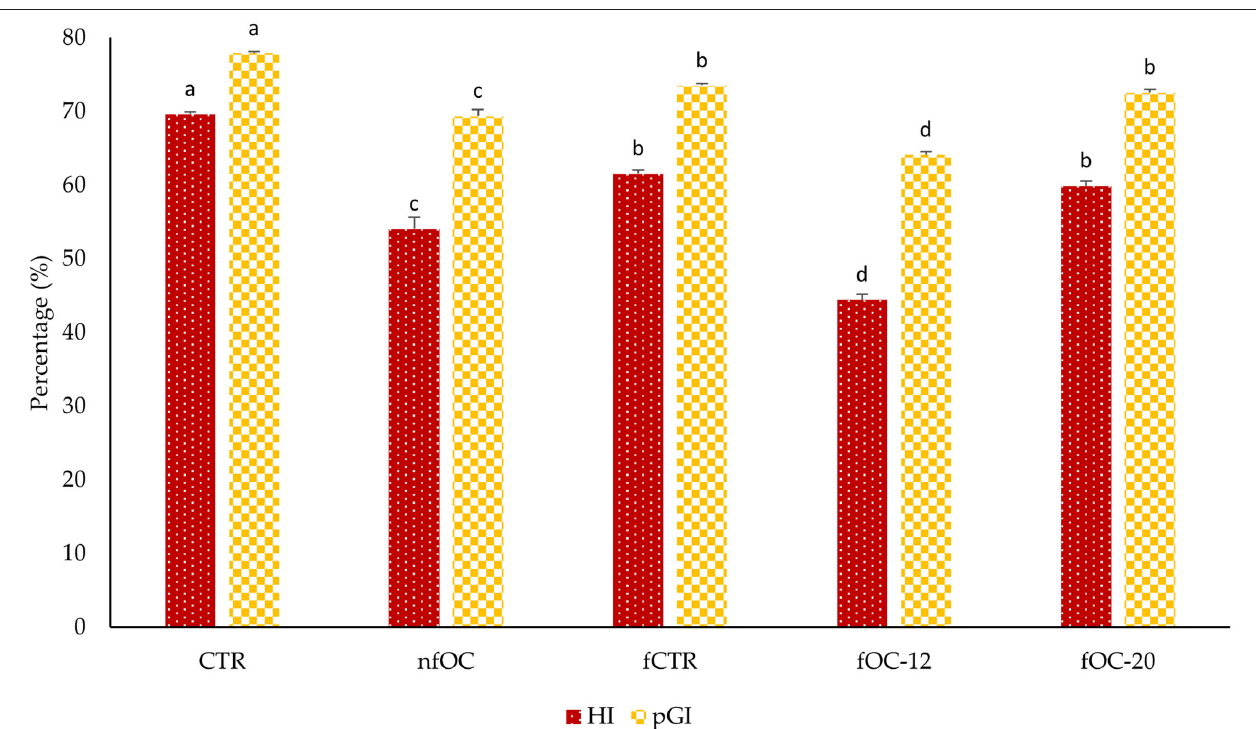
FIGURE 3 | Results of hydrolysis index (HI) and predicted glycemic index (pGI). CTR, control breadsticks obtained by the dough without OC addition and without microbial fermentation; fCTR, breadsticks obtained by the dough without OC addition and fermented; nfOC, breadsticks obtained by the dough supplementation with 1% OC without microbial fermentation; fOC-12, breadsticks obtained by the dough supplementation with 1% OC and fermented for 12h; fOC-20, breadsticks obtained by the dough supplementation with 1% OC and fermented for 20h. The values represent means of triplicates; different letters indicate significant differences ( p < 0.05) according to Tukey’s HSD